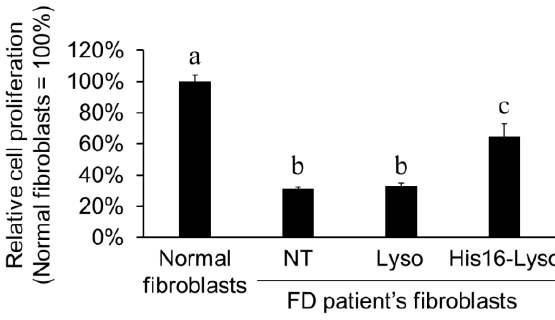
Figure 6. Enzyme replacement therapy (ERT) efficacy of His16-Lyso against FD patient fibroblasts. The FD patient fibroblasts were treated with or without His16-Lyso (10 µM STR-His16, 5.0 µg/mL lysosomes) for 72 h. NT and Lyso mean nontreated condition and unmodified lysosomes from HT1080 cells, respectively. Cell proliferation was determined by the water-soluble tetrazolium salt (WST) assay. Data represent means ± SD. Different letters indicate significant differences ( p < 0.05, Tukey’s test).